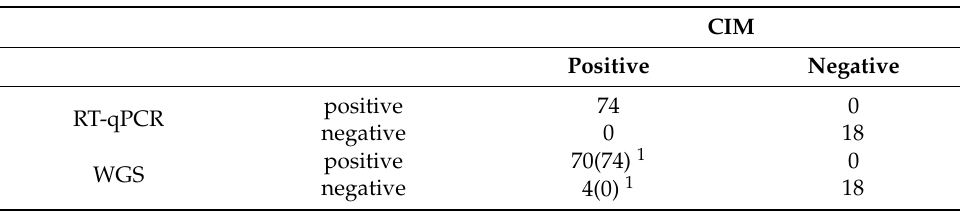
Table 1. Comparison of phenotypic and genotypic carbapenemase detection in Enterobacterales by CIM, RT-qPCR and WGS.